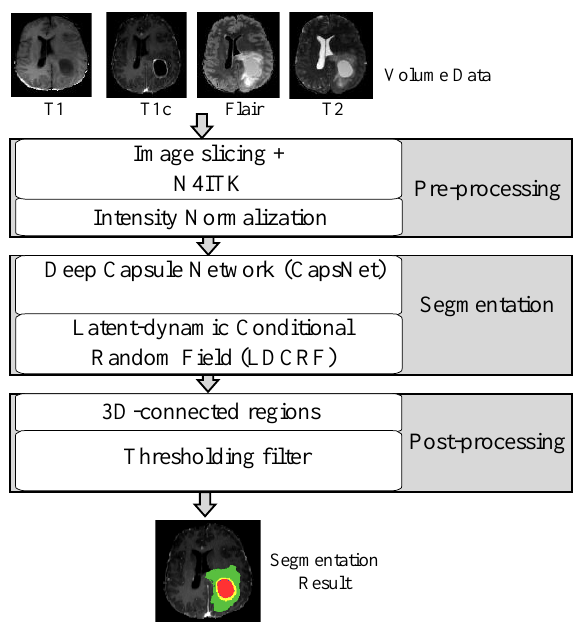
Figure 2. Structure of our suggestion with respect to three key